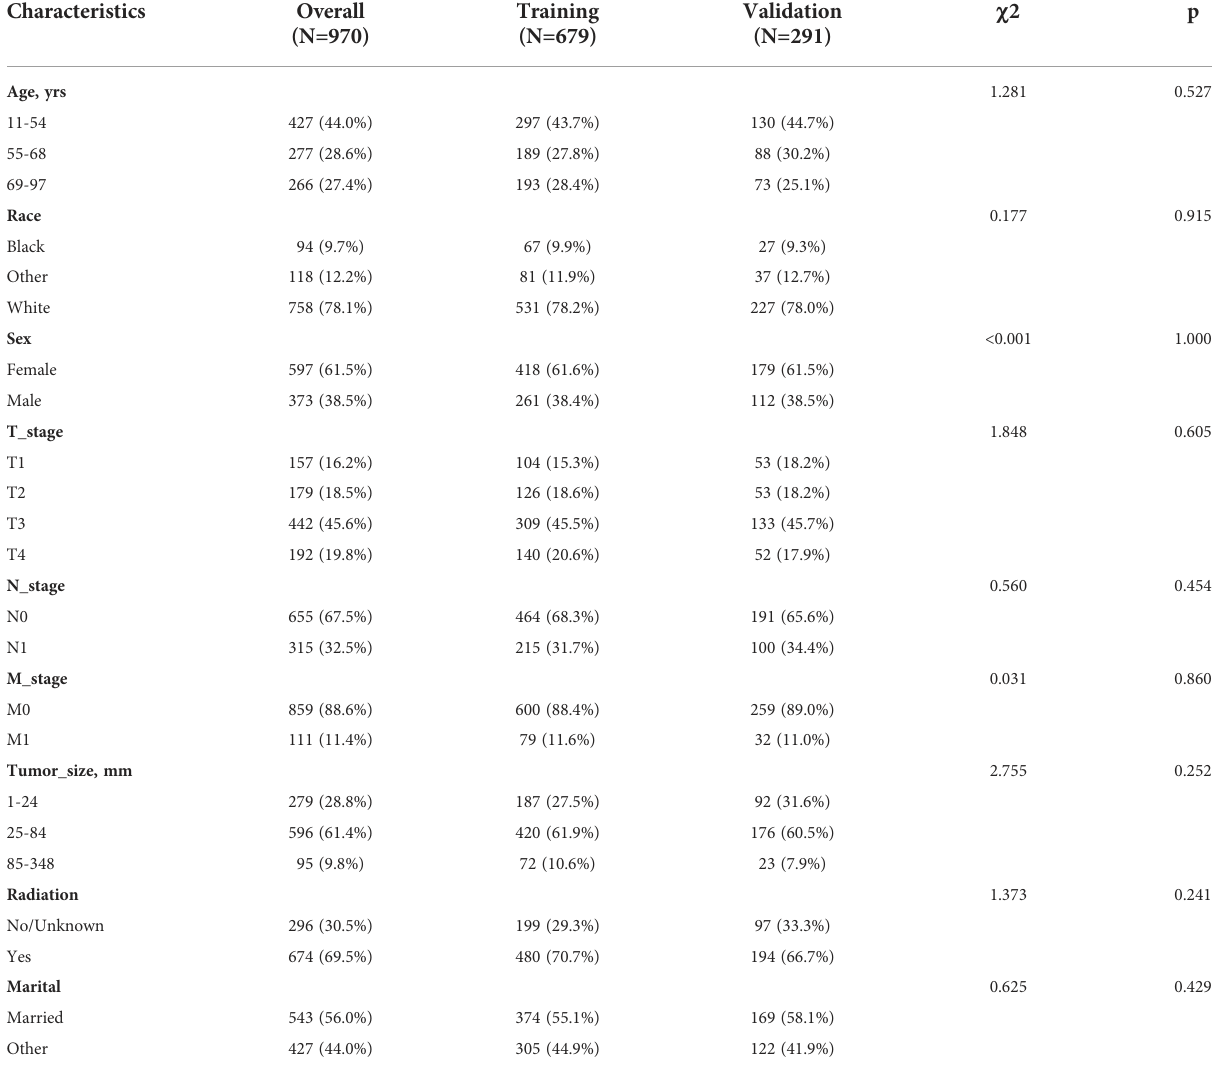
TABLE 1 Demographic and clinicopathological characteristics of PDTC